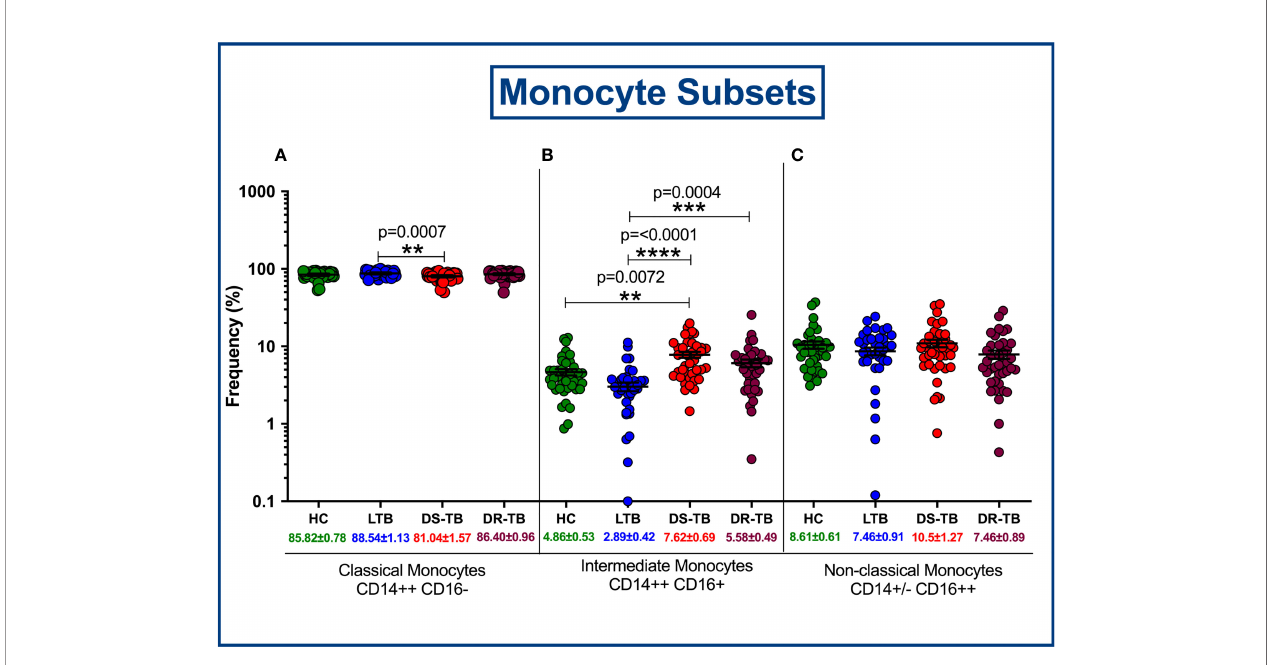
FIGURE 3 | Frequency distribution of monocyte subsets; Classical monocytes (A) , Intermediate monocytes (B) and Non-classical monocytes (C)